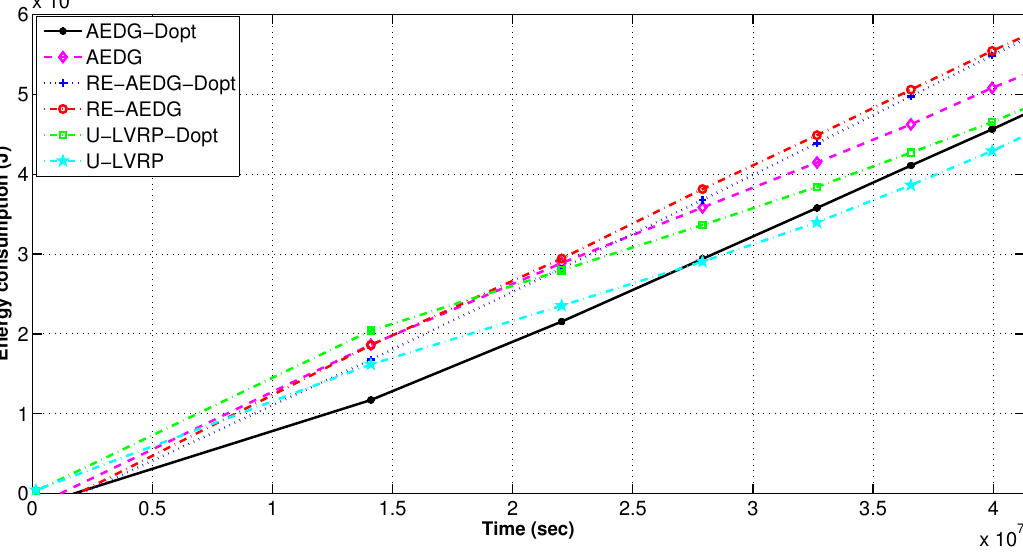
Figure 11. Energy consumption in delay optimized and non optimized